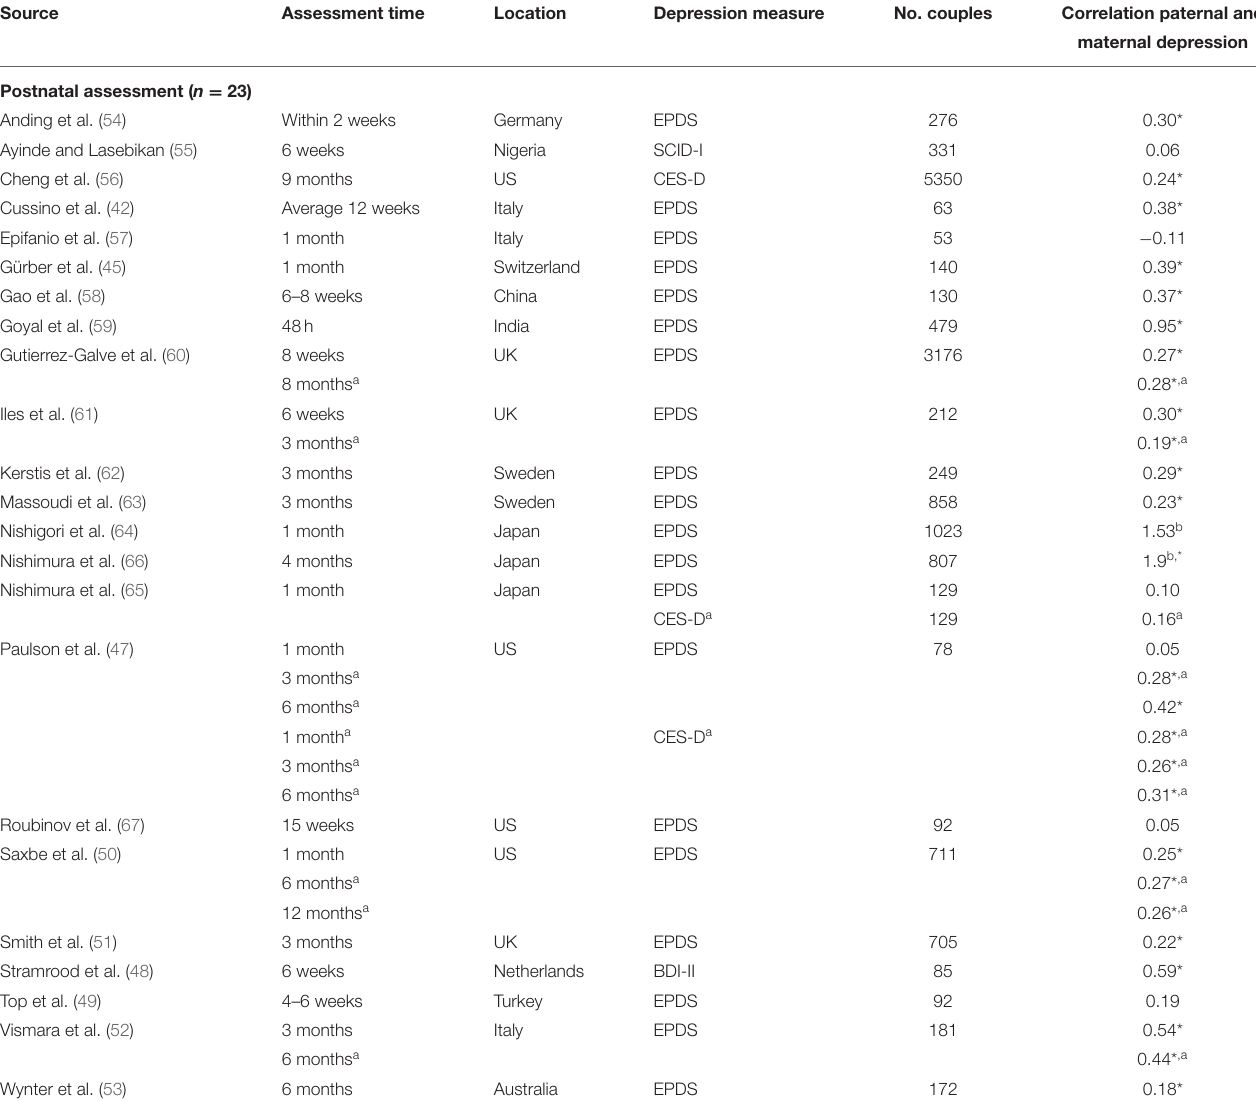
TABLE 1B | Characteristics of studies included in meta-analysis for the association between paternal and maternal depression during the postnatal